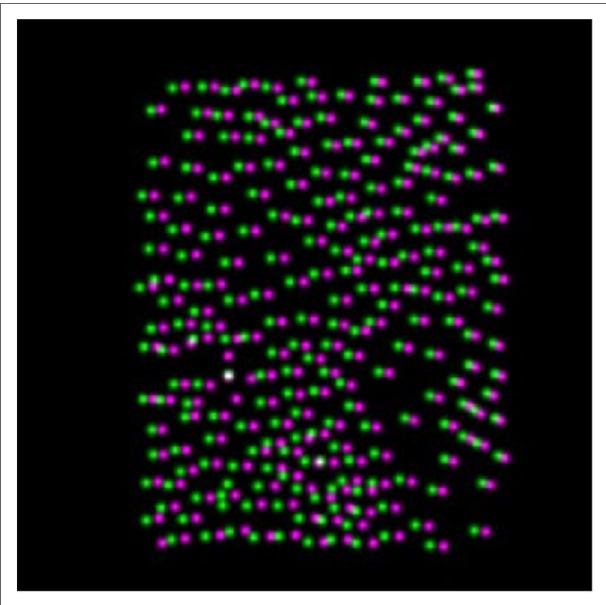
FIgURe 8 | An example of two overlaid synthetic infrared images. Markers from different images are shown with different colors.